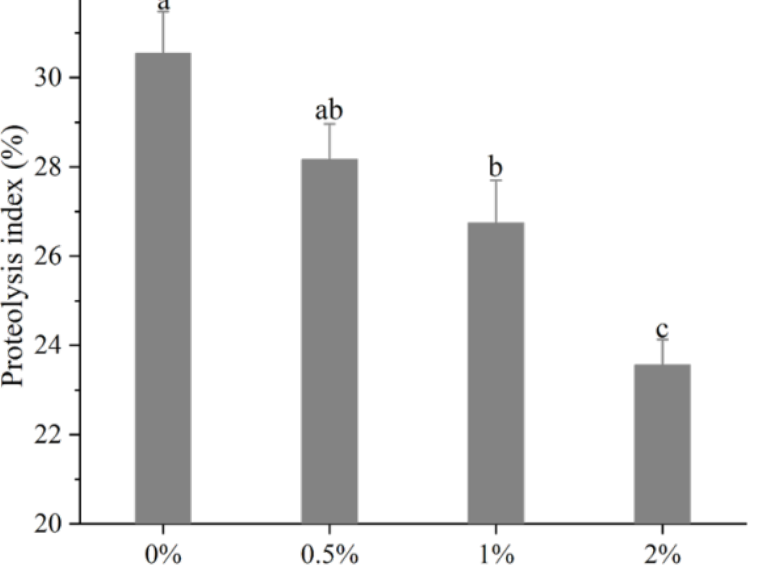
Figure 1. Changes of proteolysis index of biceps femoris muscle in Rugao hams. a–c d ifferent lowercase letters mean significant difference among four groups.